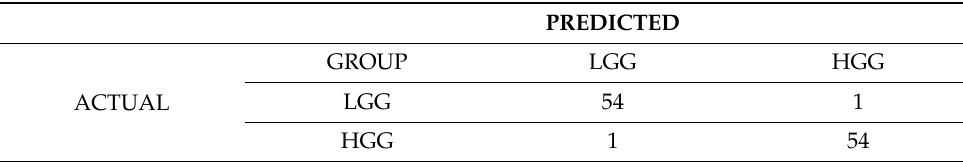
Table 1. The confusion matrix for the DNN model where the connectivity matrix was used as an image. A total of 110 test images were used.